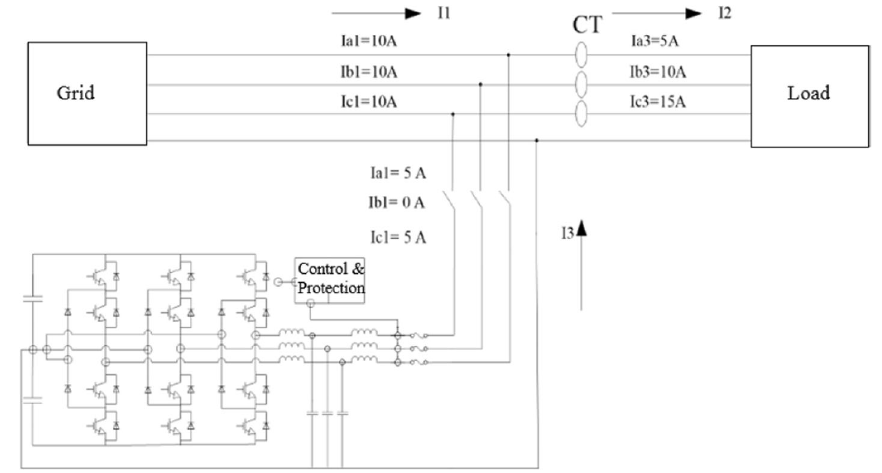
Fig. 3 Principle of SVG three-phase unbalance